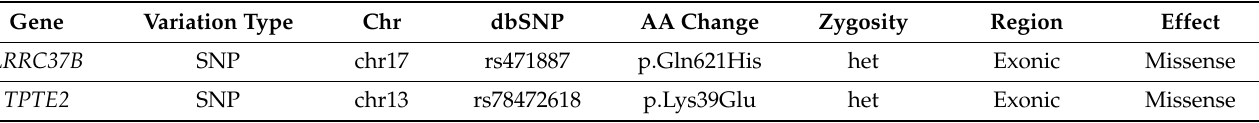
Table 2. List of genes presenting variants (SNPs and indels) only in S-RMS1 cell line.